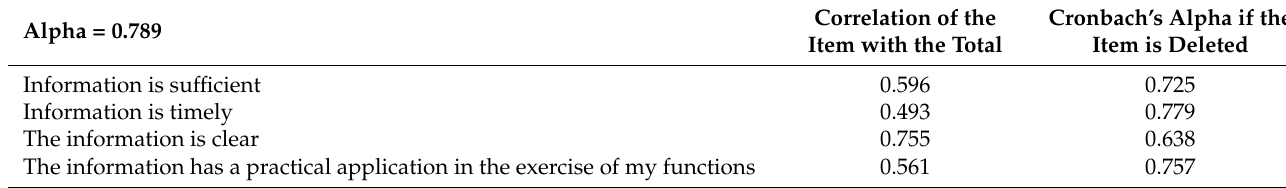
Table 4. Reliability of the “Communication with superiors” dimension.